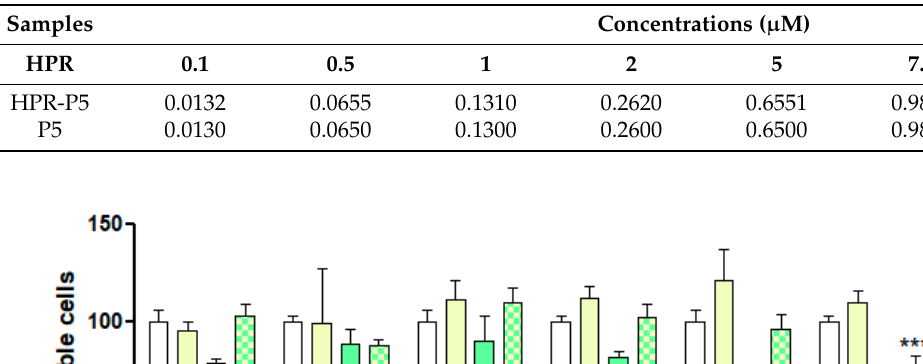
Table 2. Concentrations of each sample administered to NB cells.